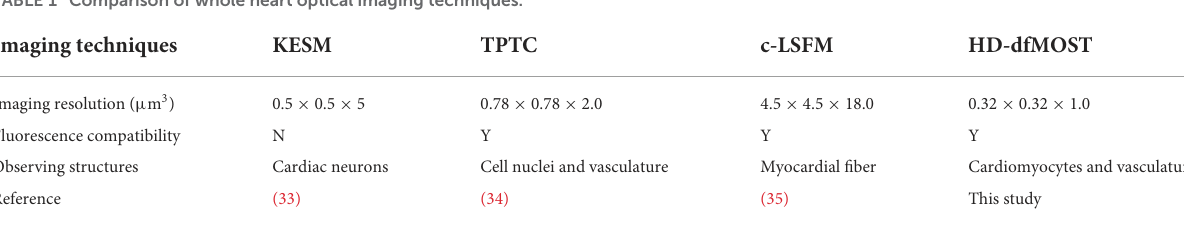
TABLE 1 Comparison of whole heart optical imaging